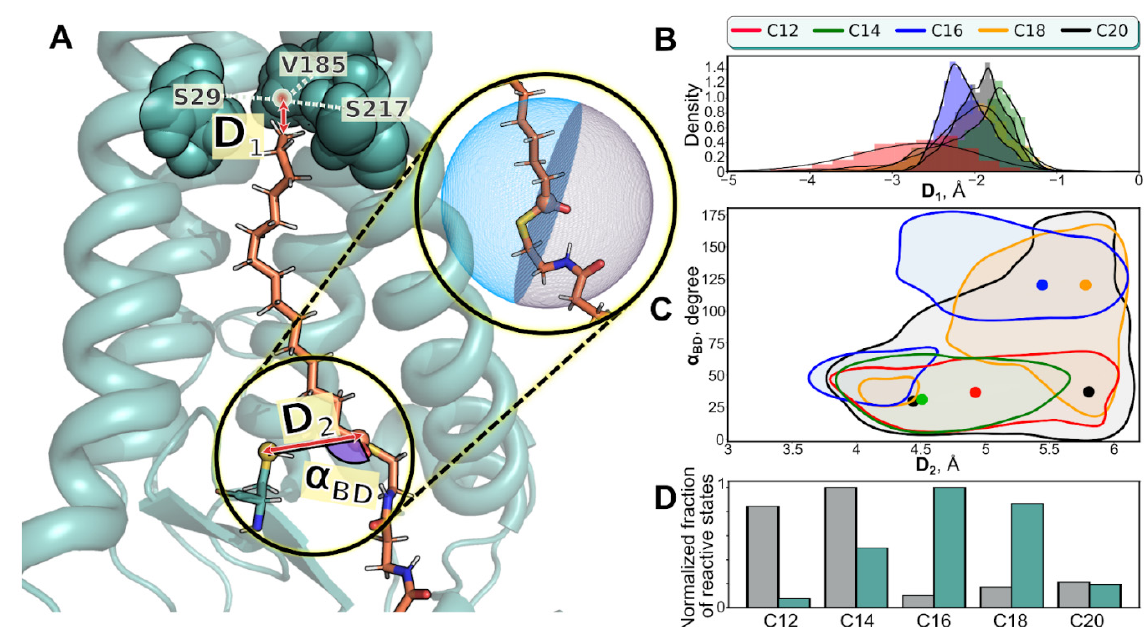
Figure 2. Positioning of the fatty acid residue inside the protein cavity and the complex reactivity during MD. ( A ). MD snapshot of hDHHC20 in complex with C16-CoA. Crucial residues of the protein ceiling (Ser 29 , Val 185 and Ser 217 ) are marked by their center of mass ( red circle ). Parameters D 1 , D 2 and α BD are illustrated. D 1 is the Δ Z value for the tail terminal C-atom and the ceiling. D 2 is the distance between the sulfur atom of the catalytic Cys 156 residue ( yellow sphere ) and the carbonyl C atom of the acyl residue ( orange sphere ). α BD is the Bürgi–Dunitz angle of the nucleophilic attack [20]; semi-transparent blue hemisphere in the inset illustrates the “right” area for Cys 156 ’s sulfur atom to be treated as reactive. ( B ). D 1 distribution for the representative set of trajectories (colored according to the legend). Time-dependencies of D 1 and D 2 are provided in Figure S3. ( C ). Contours of the high-density states in the coordinates (D 2 , α BD ) for all MD trajectories from Table 1 (replicas joined). Colored dots show the positions of the maximas of these 2D-distributions. Full version of this analysis is provided in Figure S2. ( D ). Normalized fraction of the reactive states ( in silico selectivity profile) for acyl-CoA of various chain lengths ( cyan bars ) compared to analogous profile, calculated with the “improper” α BD (<90°) ( gray bars ).